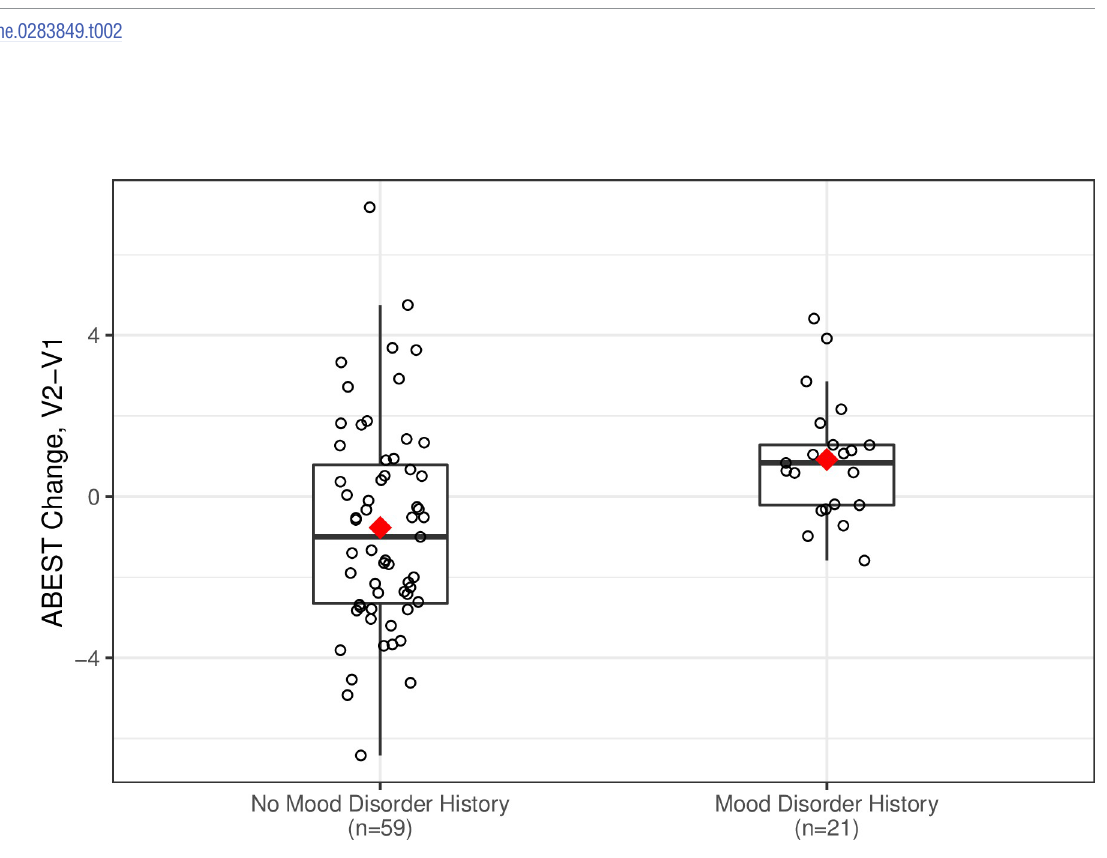
Fig 2. Mood disorder history predicts accelerated cardiopulmonary aging from pre-surgery to post-adjuvant treatment in breast cancer survivors. This boxplot depicts the unadjusted ABEST change scores from Visit 1 to Visit 2 for those with and